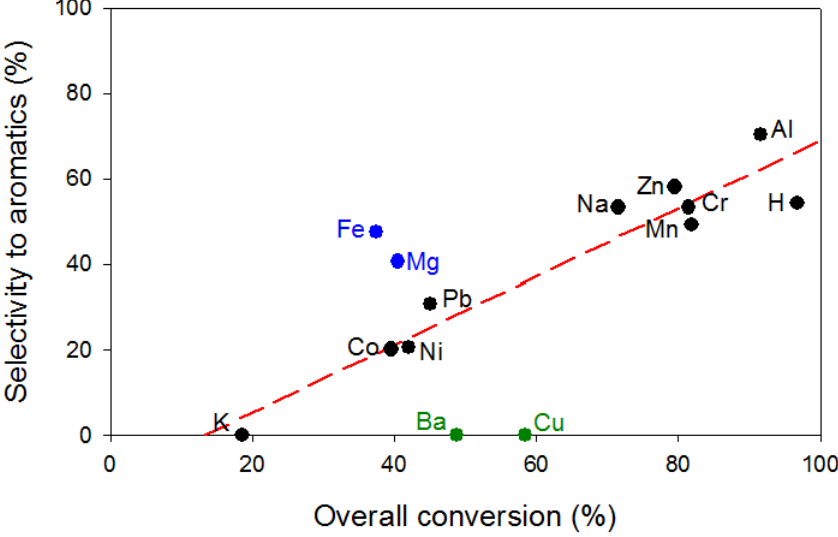
Figure 6. Relationship between the overall conversion and the selectivity to aromatic compounds in the transformation of acetone into hydrocarbons on metal exchanged zeolite β at 400